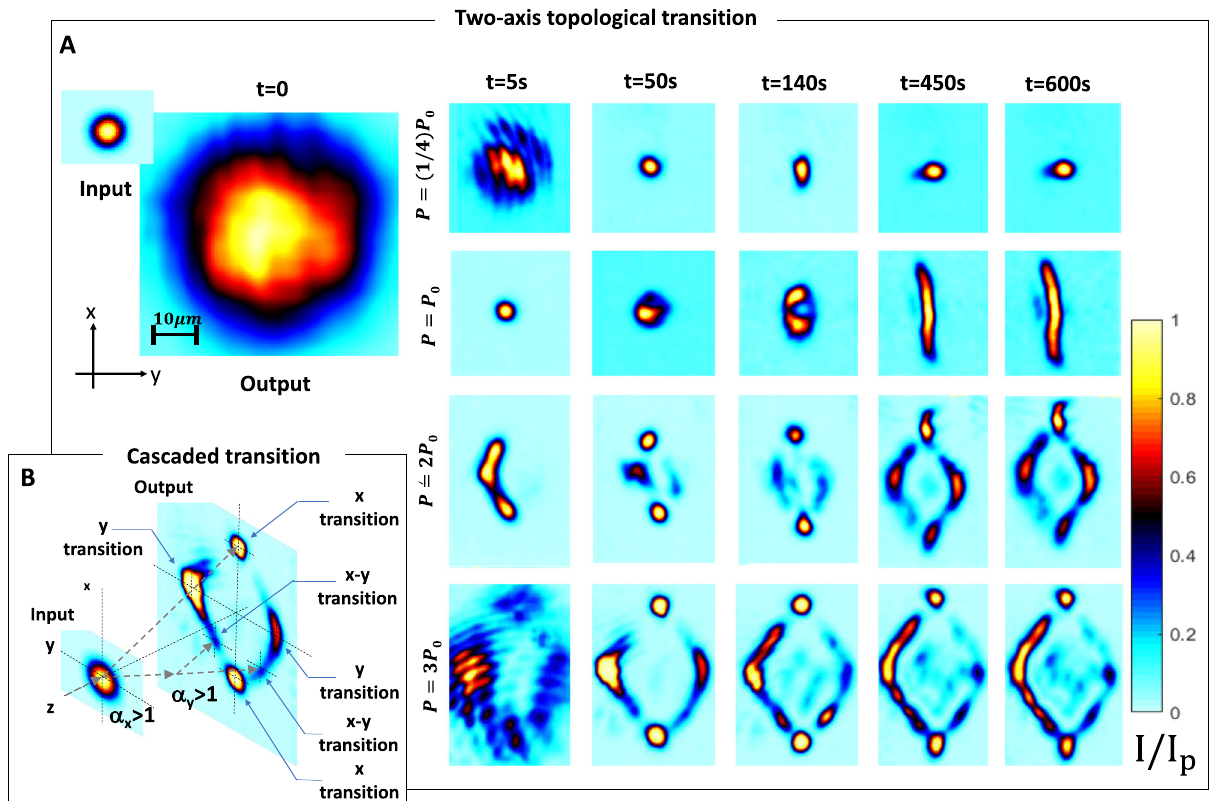
Fig. 3 Topological transitions in full 2 + 1D. A Output intensity distribution for different exposure times and different relative beam power P / P 0 (reference P = 6.5 μ W is the power used in the transition reported in Fig. 2). For P / P = 0.25 (top row), the input beam (inset left panel) initially diffracts (left panel) 0 0 after the L z = 2.2 mm propagation and reaches a scale-free optics regime at α ≃ 1 at t = 50 s, while no signature beam splitting is observed for the reported interval (from t = 0 to t = 600s). For the same interval, as P / P 0 is increased, a signature splitting is also observed along the x and then y direction, leading to a rhombus-like non-diffracting distribution. B Results are compatible with the appearance of x - and y -directed topological transitions, with α x ≠ α y , while the rhombus-like structure signals cascaded transitions dominated by topological protection (see